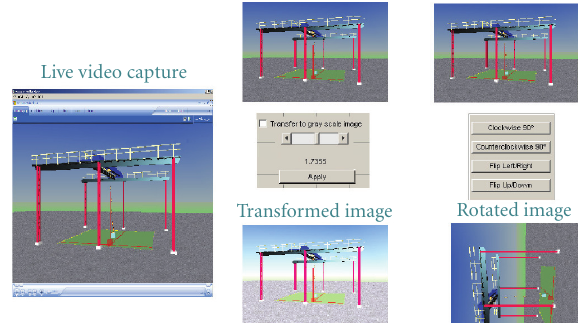
Figure 4: Snapshot of therapist panel GUI.